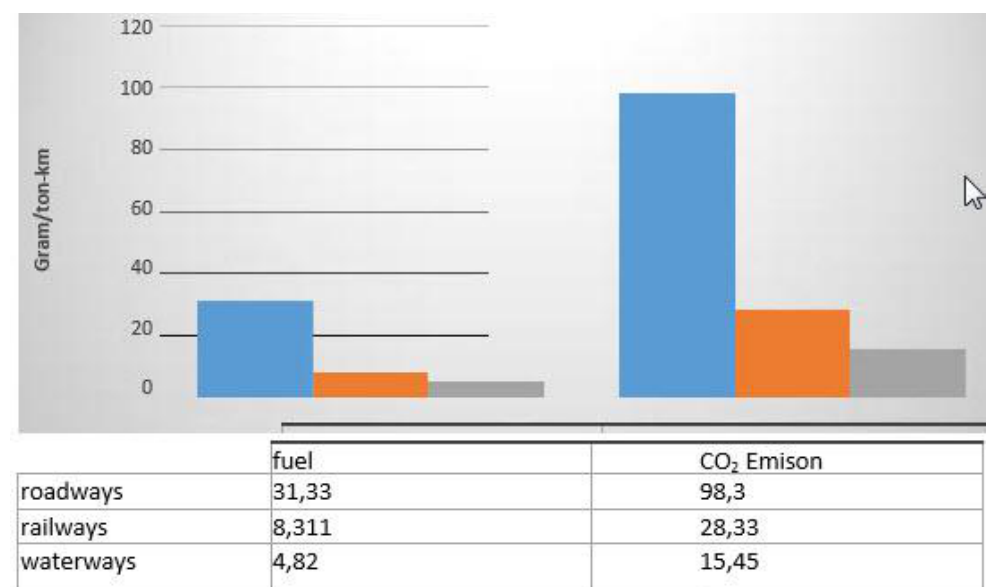
Fig 2. Average fuel consumption and CO2 emissions of transportation subsystems (Gram / ton-km). Source: International Energy Association. IEA and IPCC (2014) Summary for